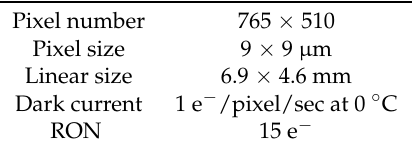
Table 1. Characteristics of the ST-7XME CCD camera.